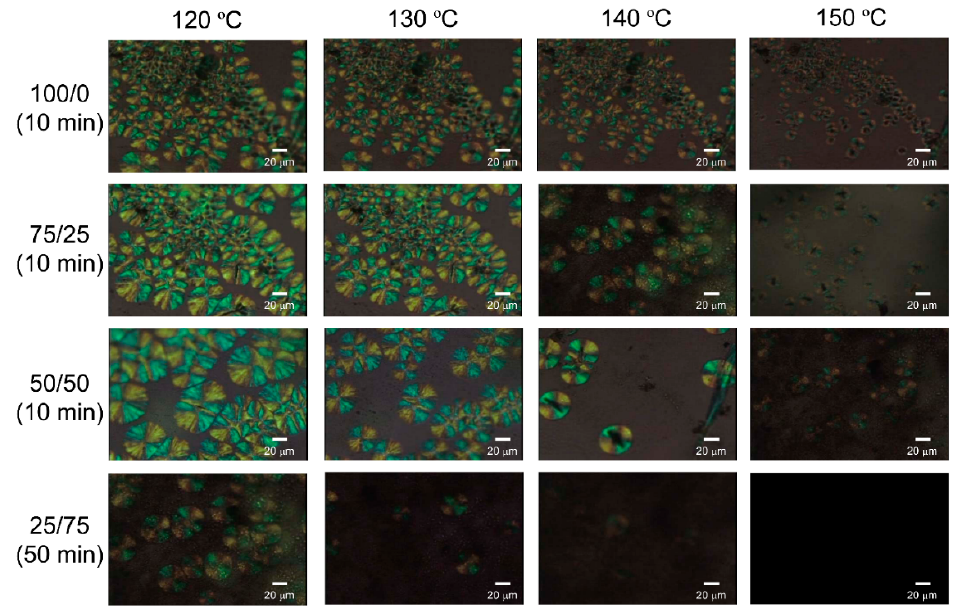
Figure 5. FE-SEM images of the fractured surfaces of PEU-3scLAO/2CLOs (100/0, 75/25, 50/50, 25/75 and 0/100).